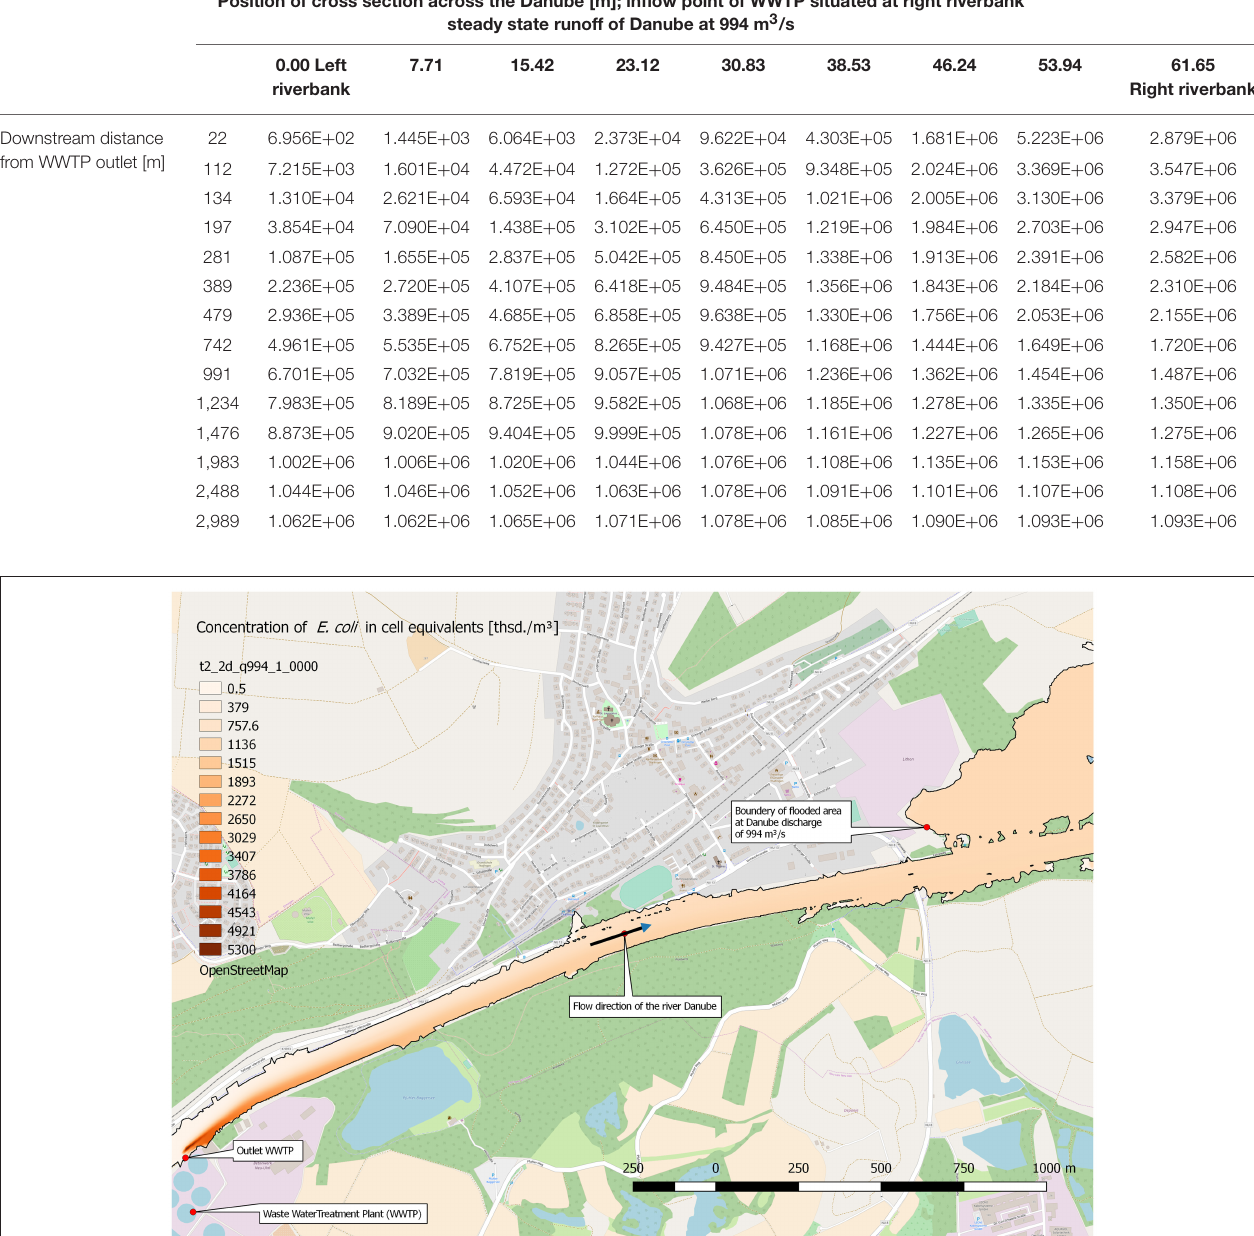
TABLE 5 | Calculated (2D-HDWAM) concentration of cell equivalents of E. coli for cross sections of the river Danube from outlet of WWTP downstream to 3,000m. Position of cross section across the Danube [m]; inflow point of WWTP situated at right riverbank steady state runoff of Danube at 994 m 3 /s